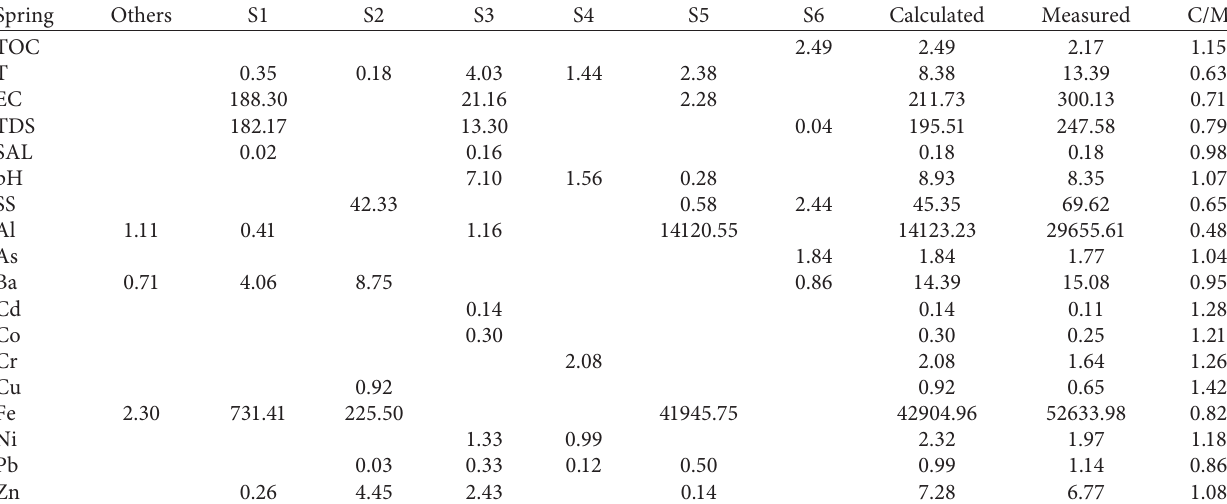
Table 4: Source apportionment for physicochemical parameters and heavy metals in spring. Spring